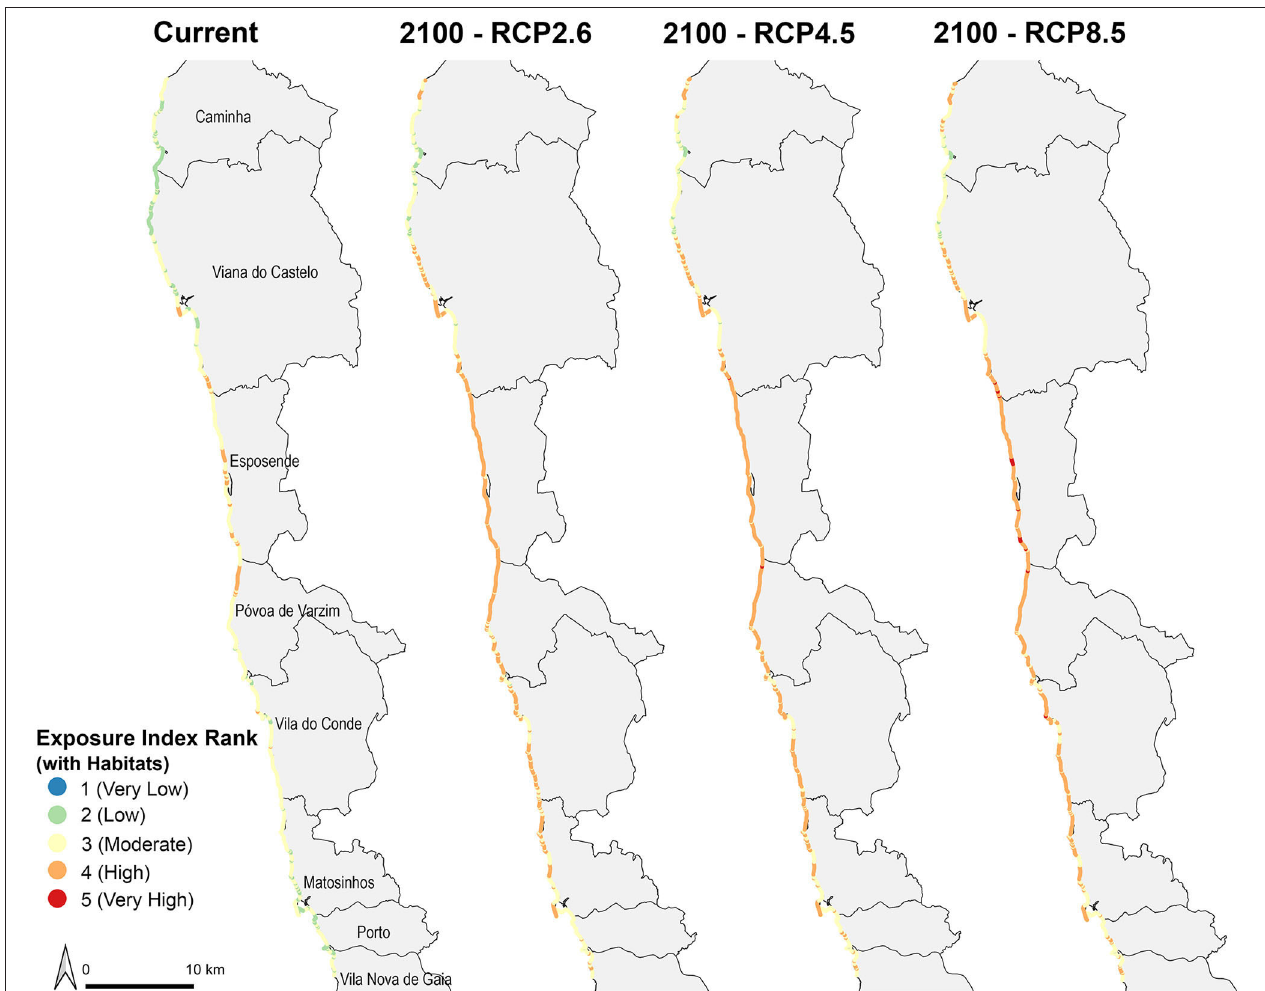
FIGURE 4 | Exposure Index values for the Current scenario and under the different RCP scenarios for 2100 for the northern coast of Portugal, with the presence of coastal habitats. RCP, Representative Concentration Pathway.